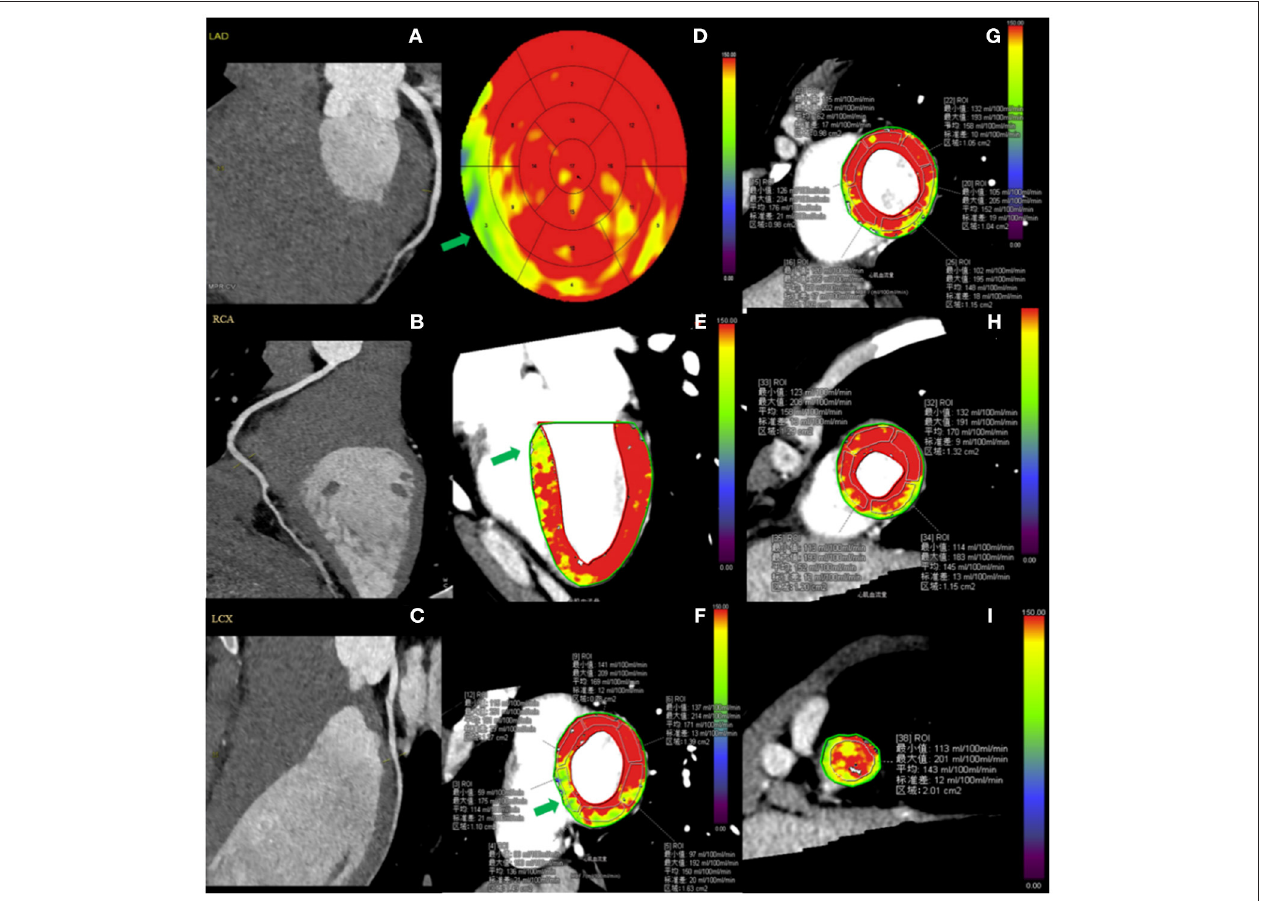
FIGURE 2 | Case example of CCTA and hyperemic MBF distribution in a healthy participant. A 29-year-old male healthy volunteer. (A–C) Resting CCTA shows no calcified plaque or stenosis in the coronary arteries. (D–I) Stress CT-MPI during adenosine infusion showed normal myocardial perfusion, as shown by relatively homogeneous color-coded images in the bull’s eye diagram (D) and left ventricular long-axis view (E) and short-axis views (F–I) . (D–F) The green arrow shows that the hyperemic MBF of basal-septum was lower than that of other segments. (F,G) ROI was manually placed in each myocardial segment as large as possible, excluding a 1mm endocardial and epicardial borders to avoid image artifacts. CCTA, coronary computed tomography angiography; CT-MPI, computed tomography myocardial perfusion imaging; MBF, myocardial blood flow; ROI, Region of